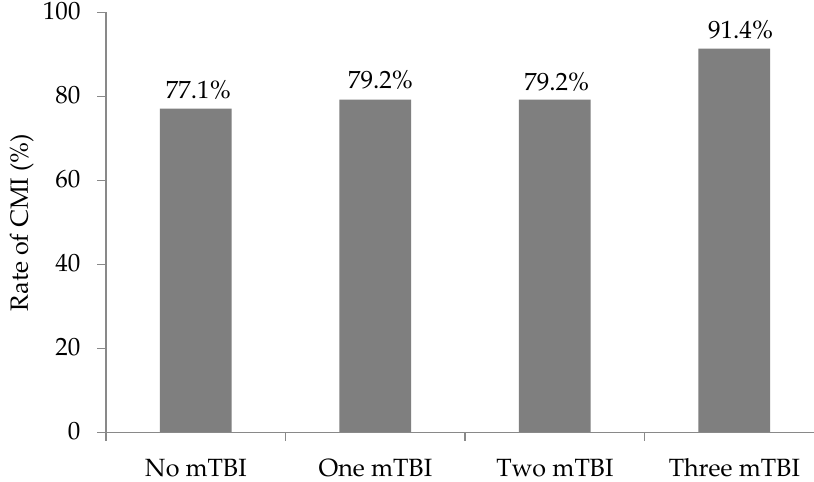
Figure 2. Rate of Chronic Multisymptom Illness by mild traumatic brain injury (mTBI) group. Six veterans are missing CMI status (2 in the no mTBI group, 2 in the one mTBI group, 1 in the two mTBI group, 1 in the three mTBI group). p = 0.035.